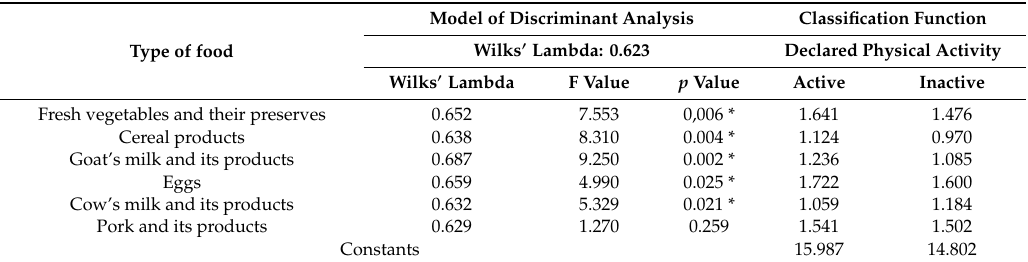
Table 2. Type of purchased organic food.